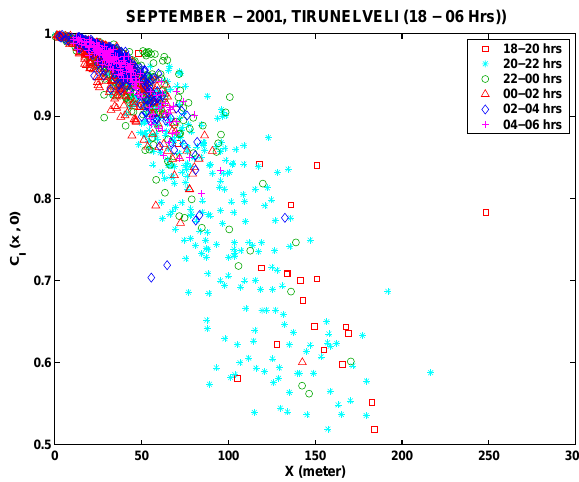
Fig. 1. Mass plot of C I (x, 0 ) as a function of x for the month of September 2001. The points are divided into 2-h bins representing different stages of evolution of the irregularities shown by different